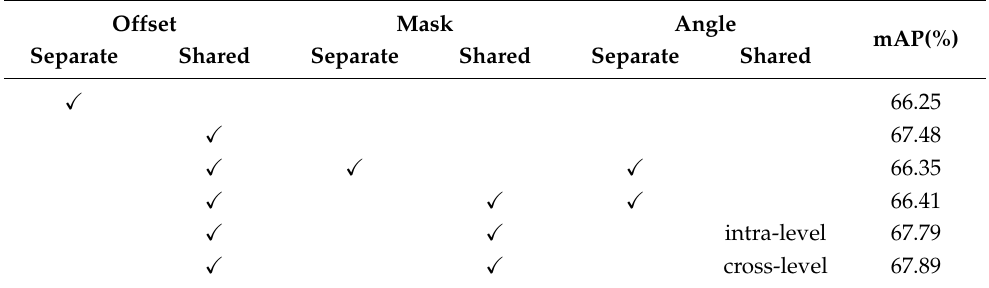
Table 5. Effectiveness of shared weights.